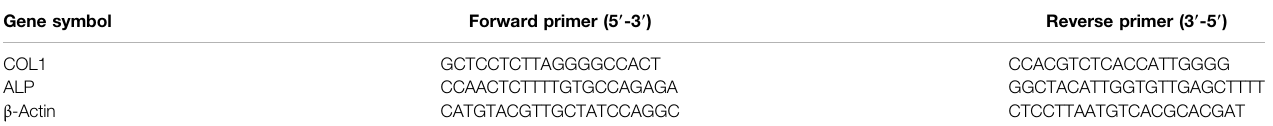
TABLE 1 | Primer sequences used for RT-qPCR analysis in the present study.